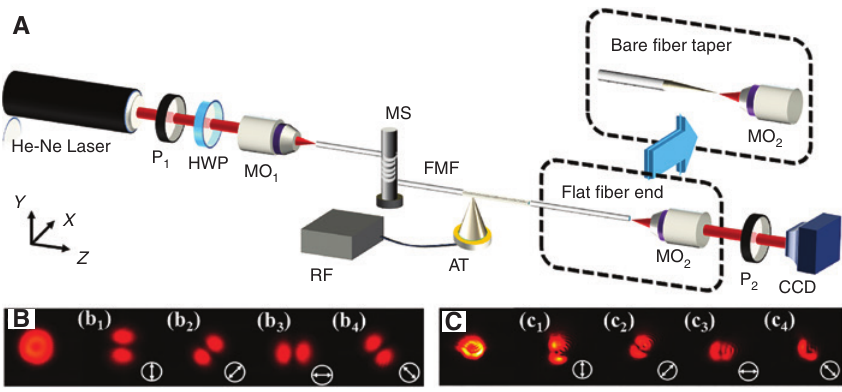
Figure 3: Generation of in-fiber RVM. (A) Experimental configuration of RVM generation and examination in FMF via AIFG. P, Polarizer; HWP, half-wave plate; MO, micro-objective; RF, radio frequency; MS, mode stripper; FMF, few-mode fiber; AT, acoustic transducer; CCD, charge coupled device. (B) Intensity distribution TM with radial polarization output from the flat fiber end and the polarization examination results. (C) Intensity distribution of OM of OM 01 with radial polarization from the conical fiber tip and the polarization examination results.